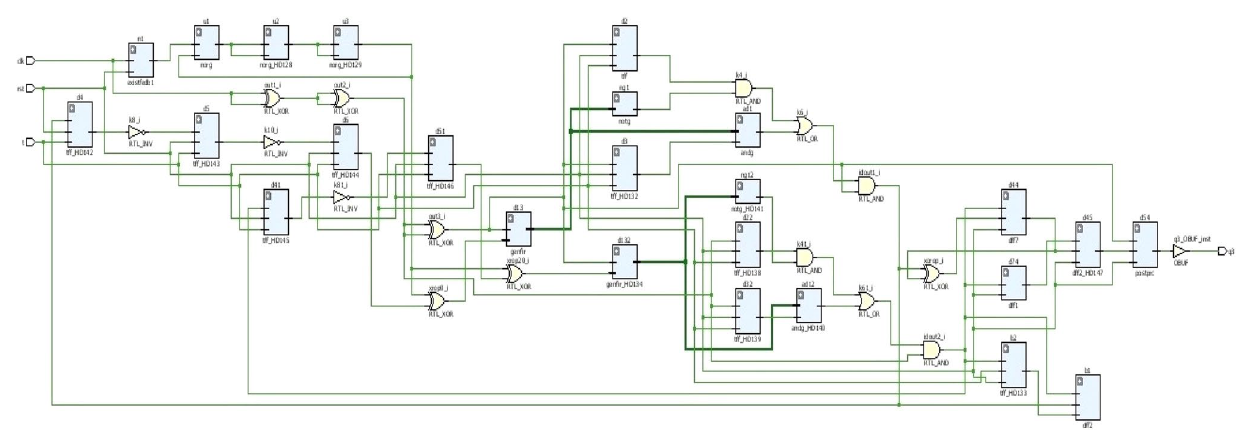
Fig. 14 Schematic diagram of FAT-1